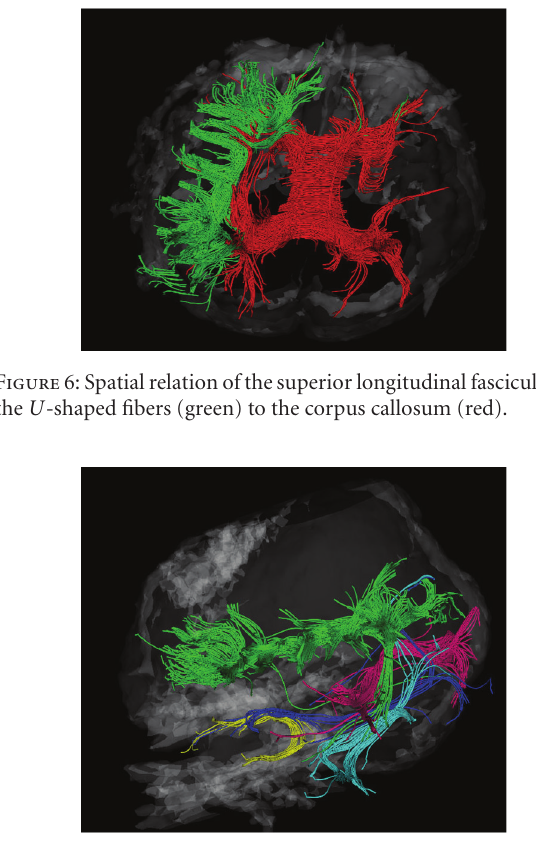
Figure 5: Spatial relation of the cingulated fasciculus (green), the fornix (purple), the uncinate fasciculus (yellow), the medial lemniscus (blue), and the pyramidal tract (red).